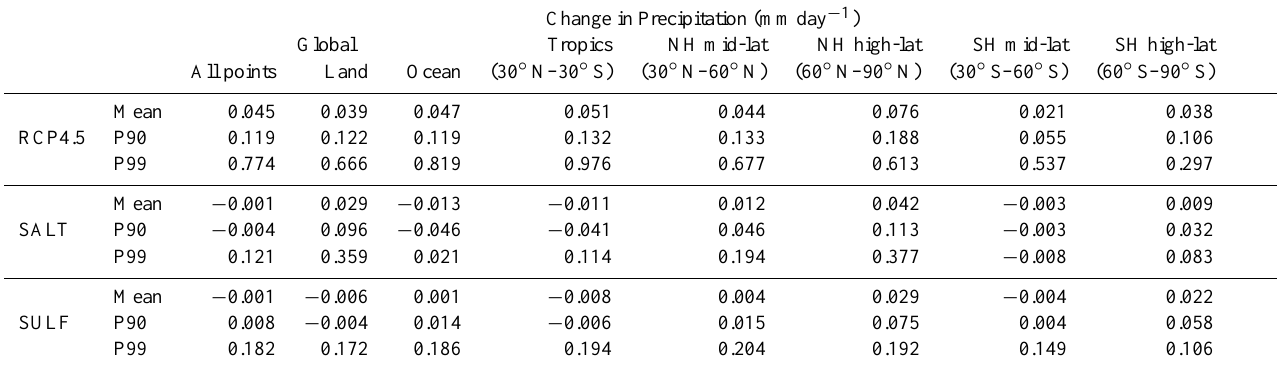
Table 3. Change in precipitation 2040 to 2069 with respect to the reference RCP4.5 2006–2035